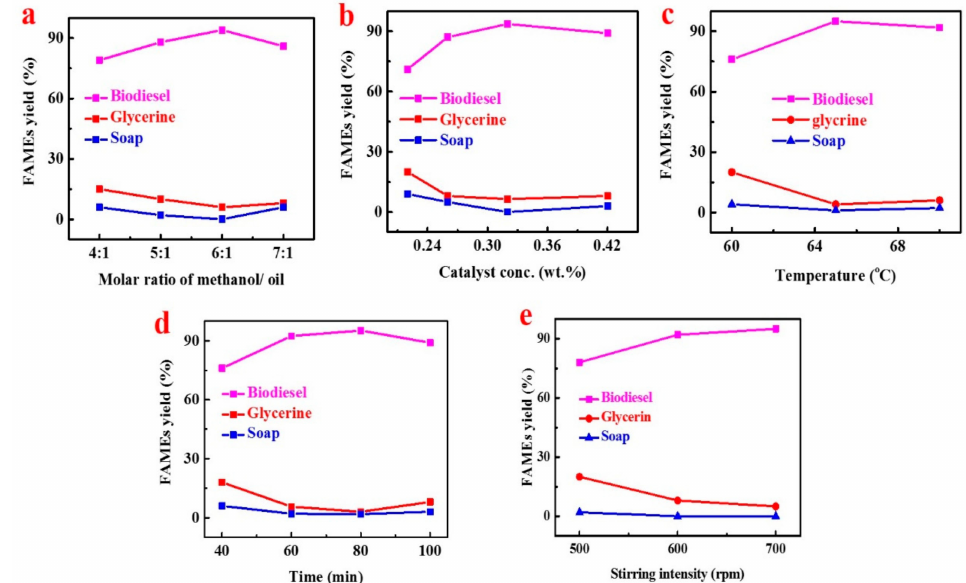
Figure 3. The e ff ect of alcohol to oil molar ratio ( a ), KOH concentration ( b ), reaction temperature ( c ), time ( d ), and agitation rate ( e ) on KPOB